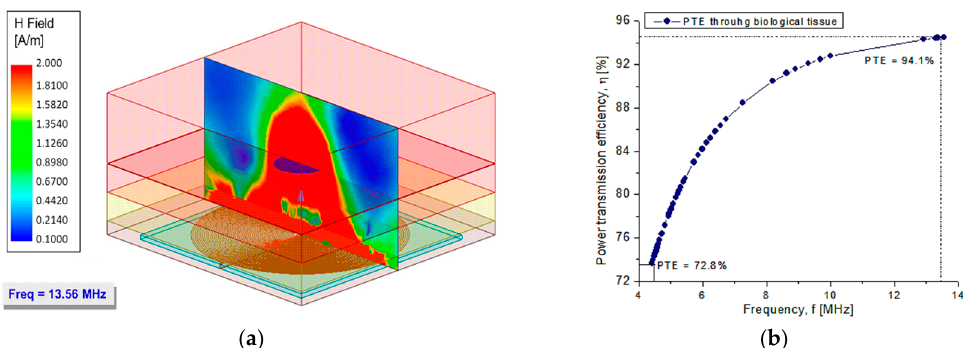
Figure 2. ( a ) Magnetic flux density of the external coupling module and ( b ) power transmission efficiency as a function of operating